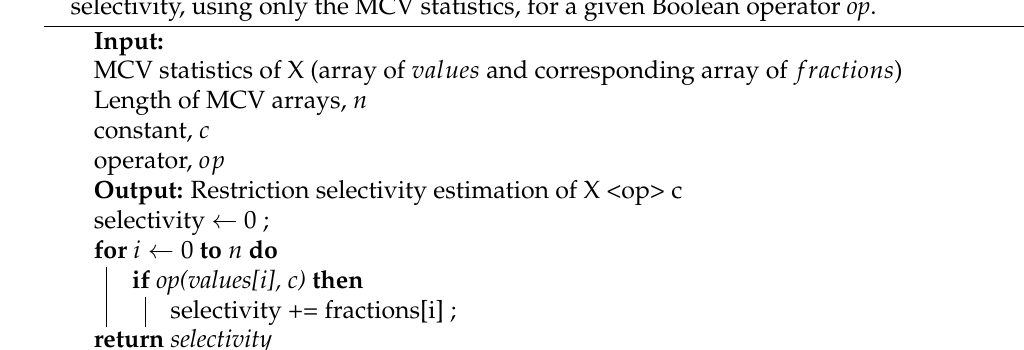
Algorithm 3: mcv_selectivity(values, fractions, n , op ), estimates the restriction selectivity, using only the MCV statistics, for a given Boolean operator op .